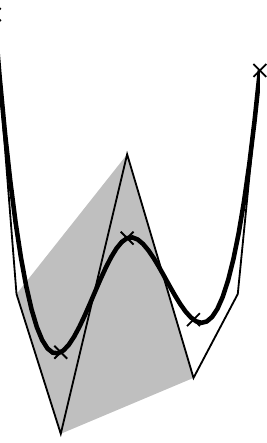
Figure 1. A continuous fourth order spline with five breaks indi- cated by the crosses. The spline’s control polygon is the broken thin line. The gray area illustrates the convex hull property for points between the second and third